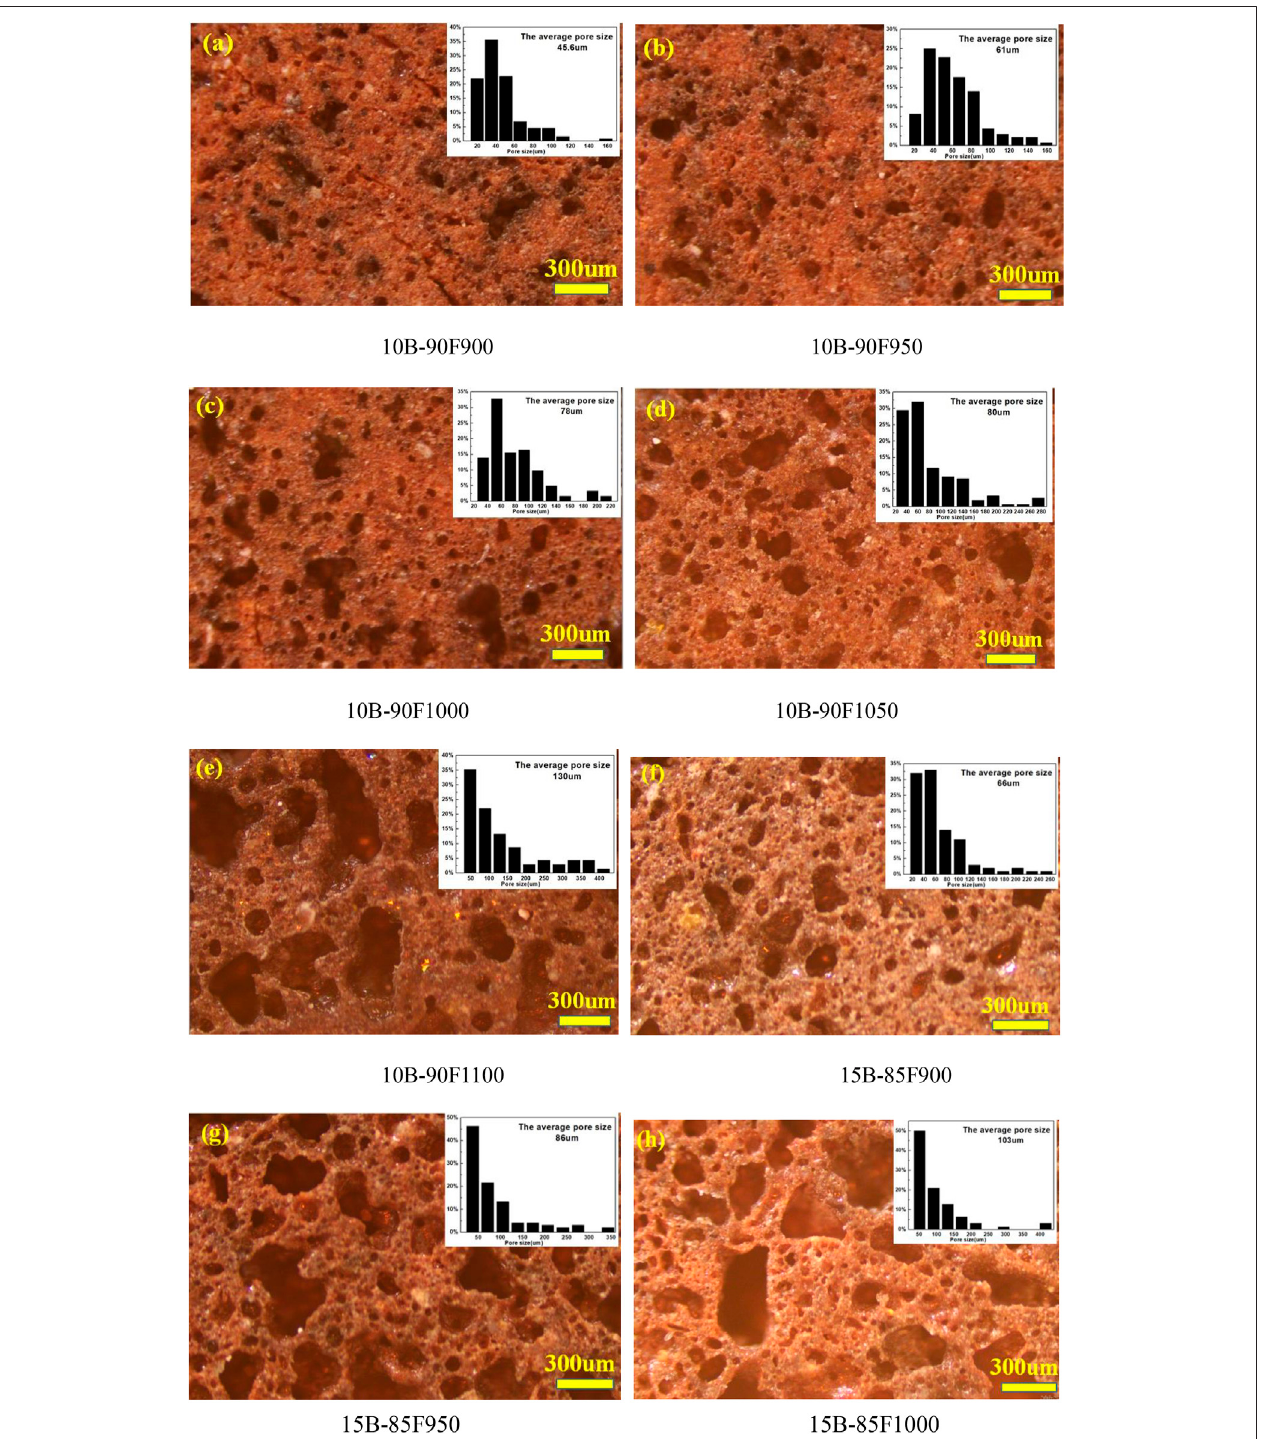
FIGURE 3 | Optical microscopy of sintered samples with different borax additives at different temperatures.